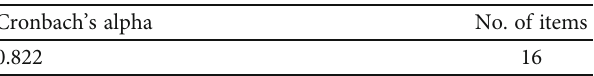
Table 7: Cronbach ’ s alpha for independent variables (CSR practices).